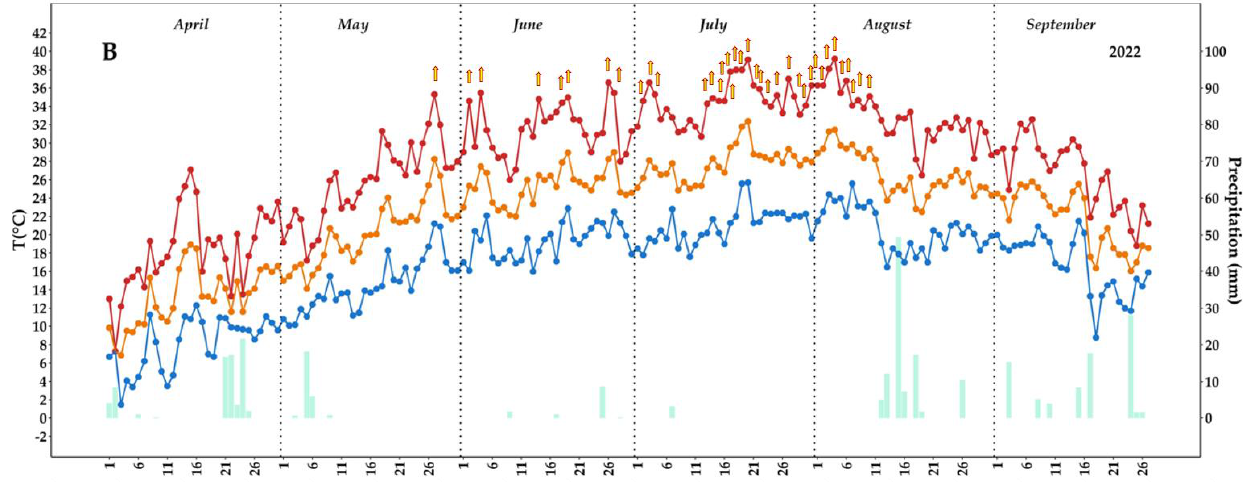
Figure 1. Weather patterns of the experiment location. Daily mean, maximum, and minimum air temperature (°C) and rainfall (mm) were measured from April to September (2021 – 2022, ( A ) and ( B )). The arrows indicate the days during which the maximum temperature exceeded 34 °C.